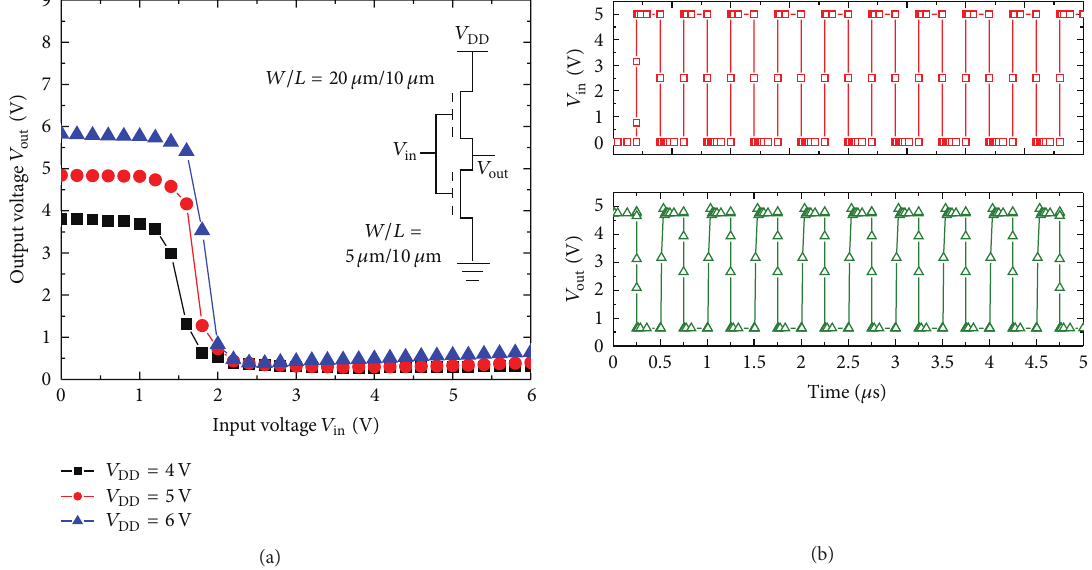
Figure 3: (a) Voltage transfer characteristics of an inverter formed using two ambipolar nc-Si TFTs with 20 nm HfO 2 gate dielectric measured at different operating voltages. (b) Operation of the inverter at 2MHz input frequency and 𝑉